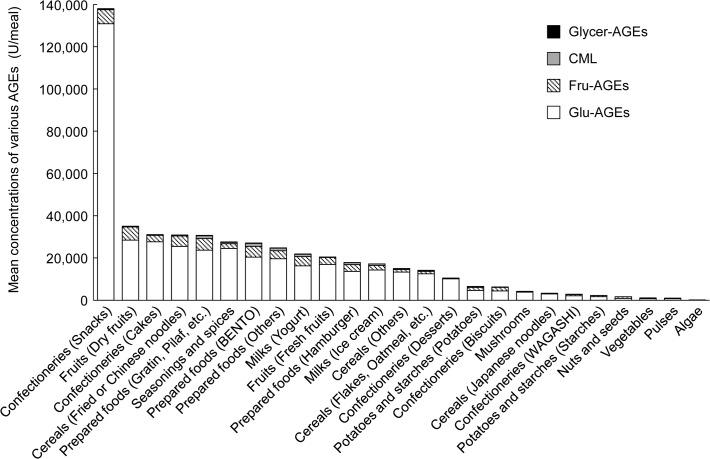
Mean concentrations of various AGEs in commonly consumed foods.Food items were classified according to the Standard Tables of Food Composition (5th revised and enlarged edition, 2009). The mean concentrations of four kinds of AGEs (Glu-AGEs, Fru-AGEs, CML, and Glycer-AGEs) in each food item are expressed as AGE units (U) per meal and are based on the standard servings consumed by average individuals in Japan.